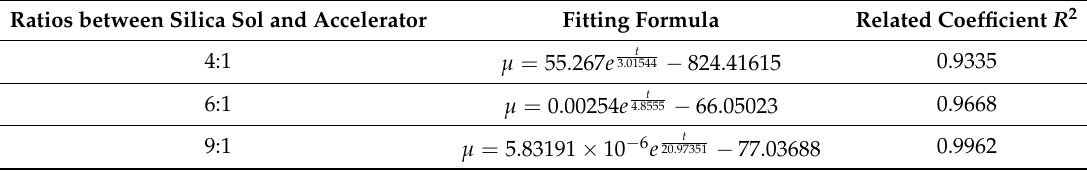
Table 3. Fitting formula of time-varying curves of viscosity with different ratios. Ratios between Silica Sol and